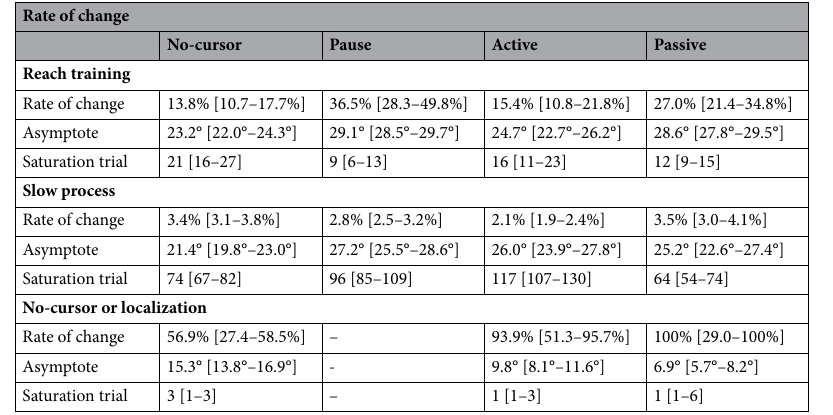
Table 1. Rate of change and asymptote for reach training trials and measures of implicit learning, for each of the experimental groups, calculated for the first rotation. Reach training trials are represented in the first three rows, then the slow process predicted by the model, with the final three rows being the implicit measure test trial associated with that training group. Averages with 95% CI are reported for all values.